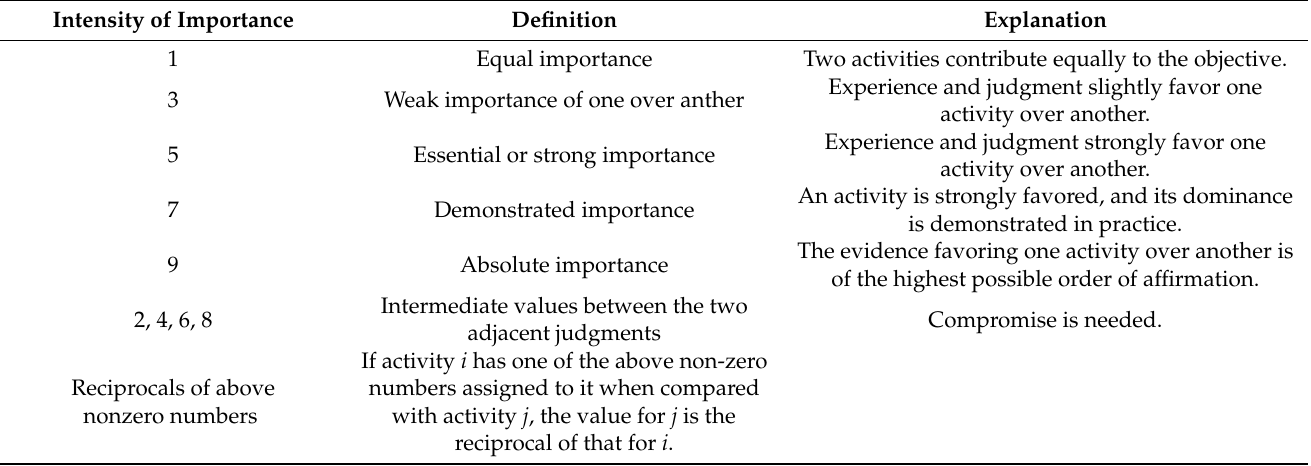
Figure 5. Evaluation procedure of the proposed method. Table 7. The 1–9 fundamental